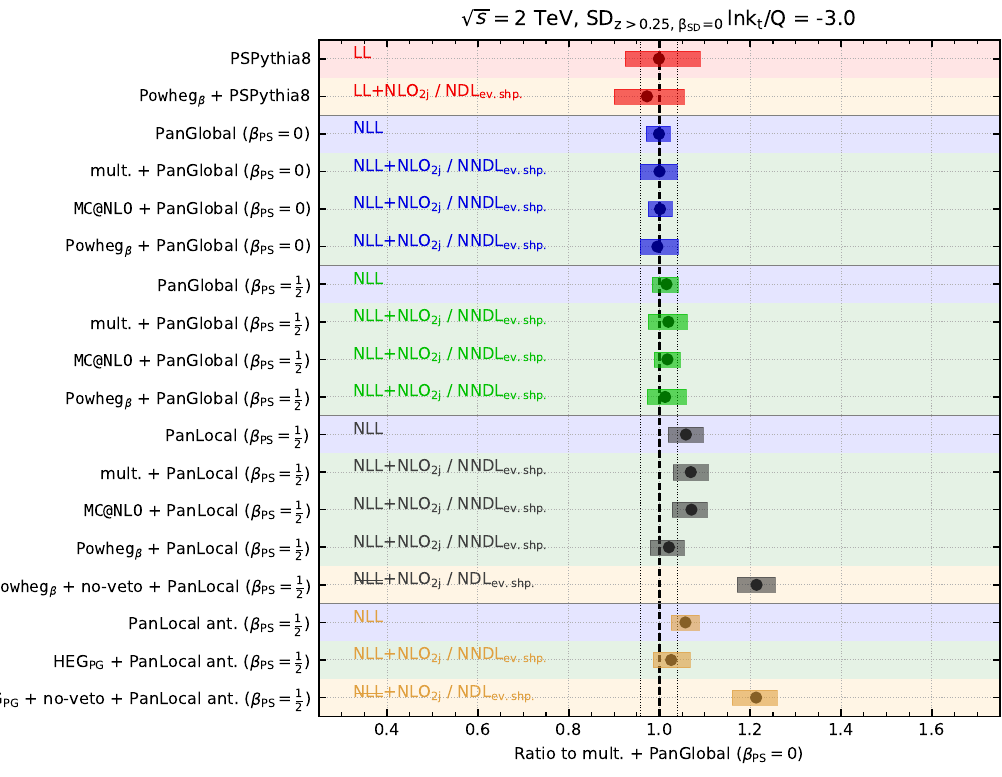
Figure 11. Analogue of figure 10 for the k t /Q distribution of the splitting from the SoftDrop ( z = 0 . 25 , β = 0 ) procedure, in a bin − 3 . 1 < ln k cut SD